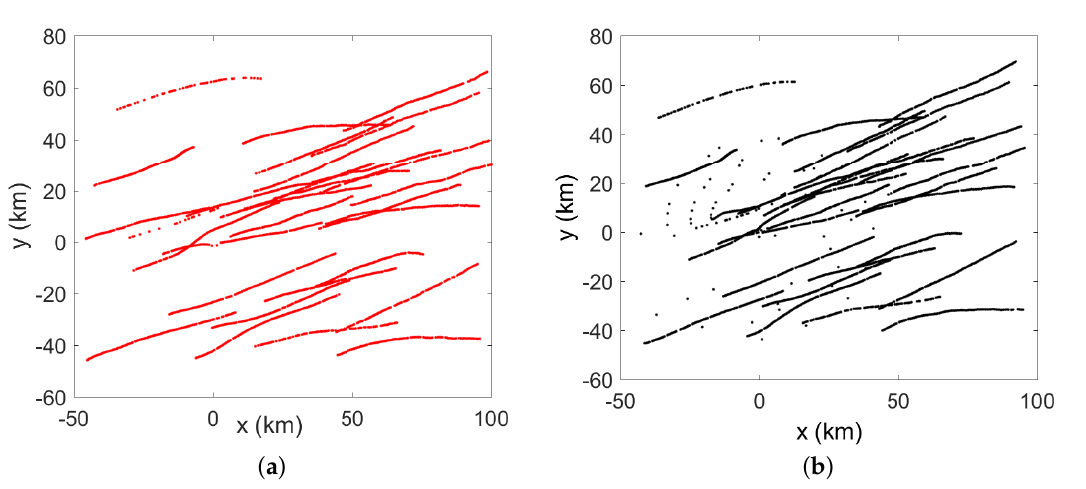
Figure 3. ( a ) Local tracks from sensor 1 ( b ) Local tracks from sensor 2.